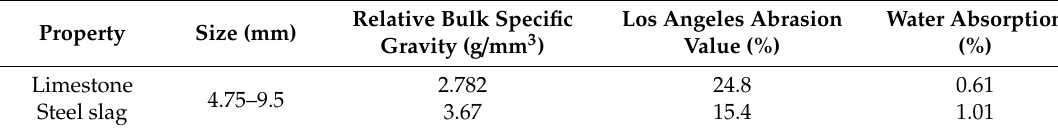
Table 2. Basic characteristics of aggregates used.